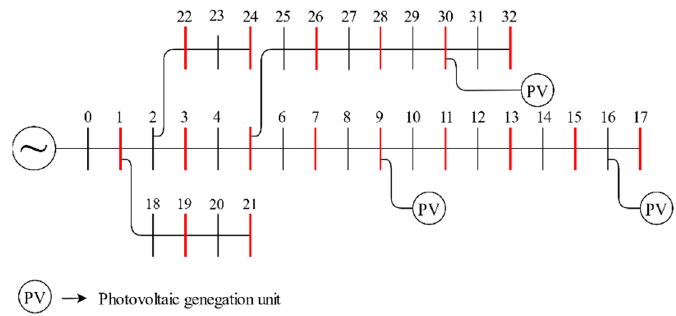
Figure 3. IEEE 33-node test system (candidate nodes in red).